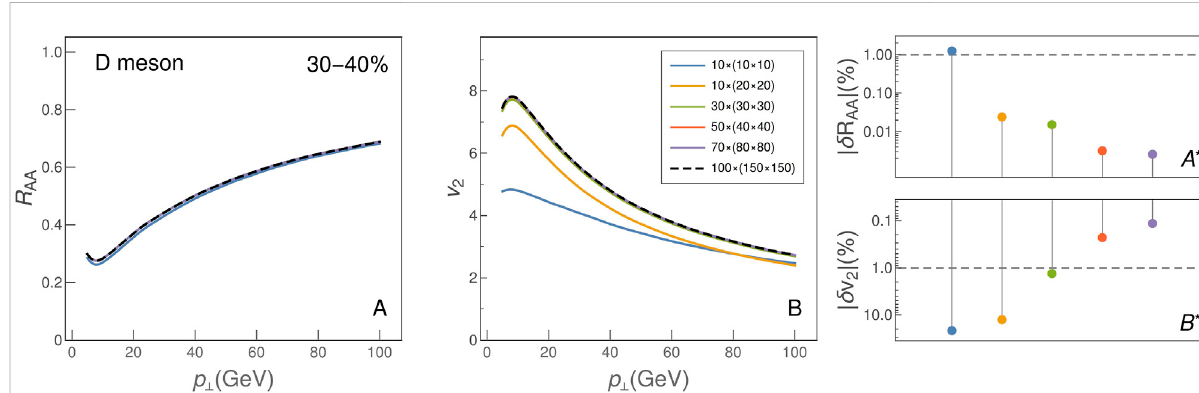
FIGURE 2 D meson R AA (left) and v 2 (middle) at 30 – 40% centrality computed using different numbers of trajectories originating from equidistant points. Results arelabeledbynumbers n ϕ ×( n x × n y ):jet directions arealong n ϕ uniformly distributedangles (from 0to 2 π )originating fromeach pointofthe n x -by- n y equidistant grid in the transversal plane. Deviation of each line from the baseline result (chosen as the outcome for 100 × (150 × 150) trajectories, dashed line) is shown in right panels. M = 1.2 GeV, μ M / μ E = 0.5.